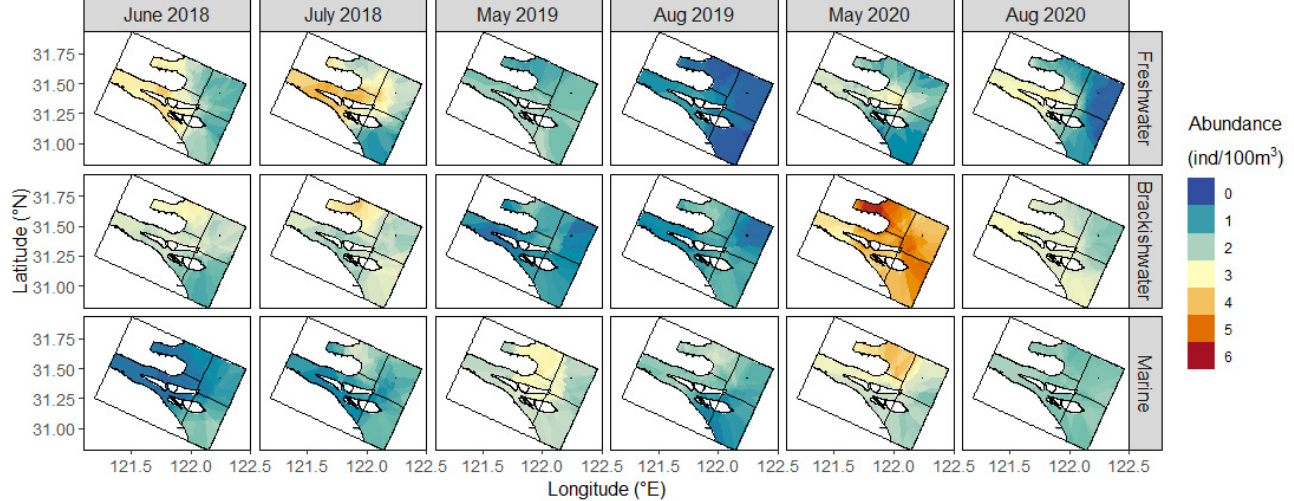
Figure 6. Mean abundance (log (ind. /100 m 3 )) of four mainly dominant species collected during six cruises (( A ), Hemiculter bleekeri ; ( B ), Pseudolaubuca sinensis ; ( C ), Coilia mystus ; ( D ), Engraulis japonicus ).